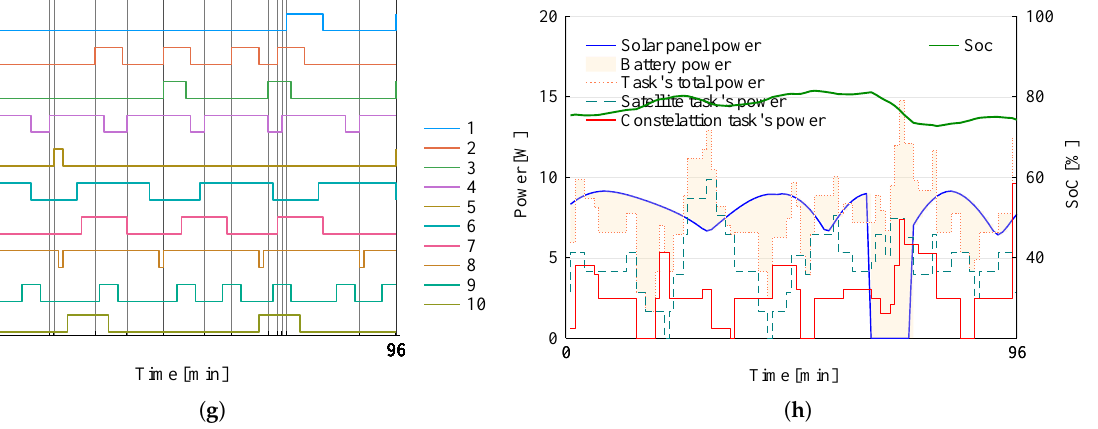
Figure 7. Mission planning for the two-satellite constellation, accounting for term C in the objective function. ( a ) Scheduling in satellite 1. ( b ) Energy in satellite 1. ( c ) Scheduling in satellite 2. ( d ) Energy in satellite 2.